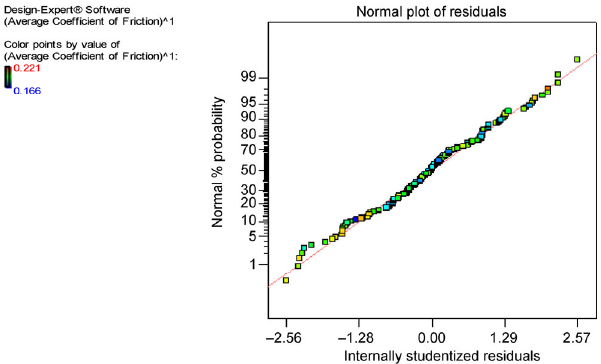
Fig. 10 Normal plot of residuals for the average coefficient of friction.